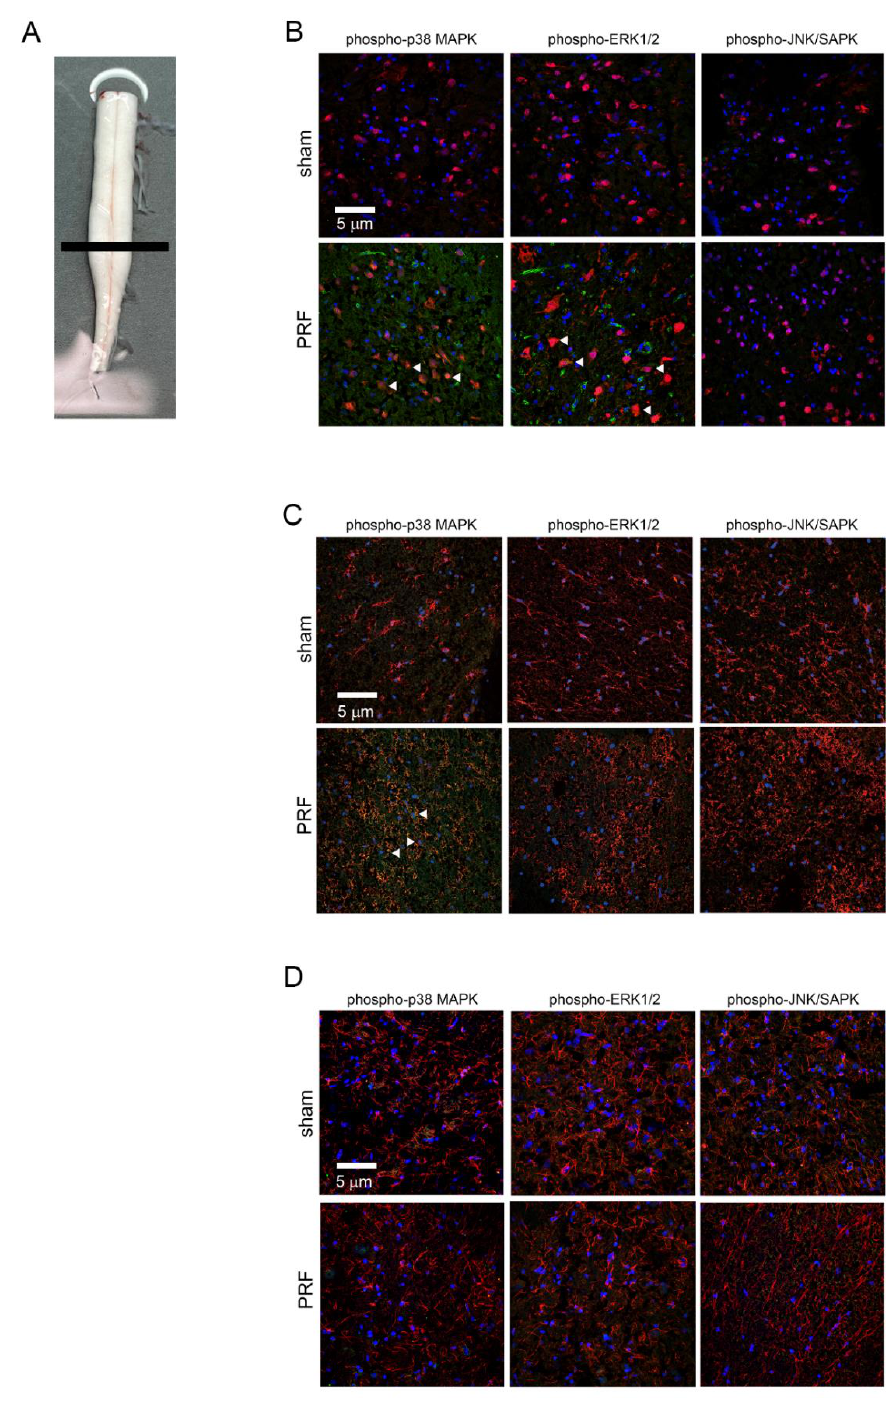
Figure 4. The spinal cords were obtained from Wistar rats that had undergone PRF stimulation for 28 days. The tissue photograph of spinal cord demonstrated the level of section ( A ). The spinal cord slides were stained using anti-NeuN, anti-CD11b, or anti-GFAP conjugated Rhodamine antibodies to identify neuron cells ( B ), microglial cells ( C ), and astrocytes ( D ), respectively (red). Additionally, the phosphorylated p38 MAPK, phosphorylated ERK1/2, and phosphorylated JNK/SAPK were stained by anti-phosph p38 MAPK, anti-phosph ERK1/2, or anti-phosph JNK/SAPK conjugated Alex 488 antibodies. The photo shows the dorsal horn of the spinal cord. The arrows indicate the phosph-p38 MAPK, phosph-ERK1/2, and phosph-JNK/SAPK expressions (green) in the Figure ( A – C ). The DAPI staining for the nucleus of the cells and photo presented in the magnification of 200 ×